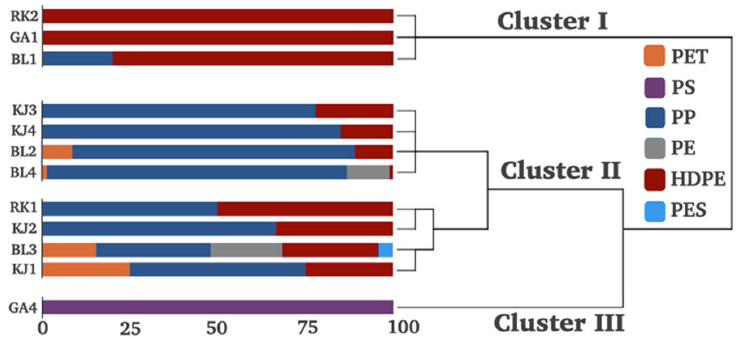
Figure 5. Hierarchical cluster analysis and compositional profiles of MPs in the sediments of East Surabaya, Indonesia.